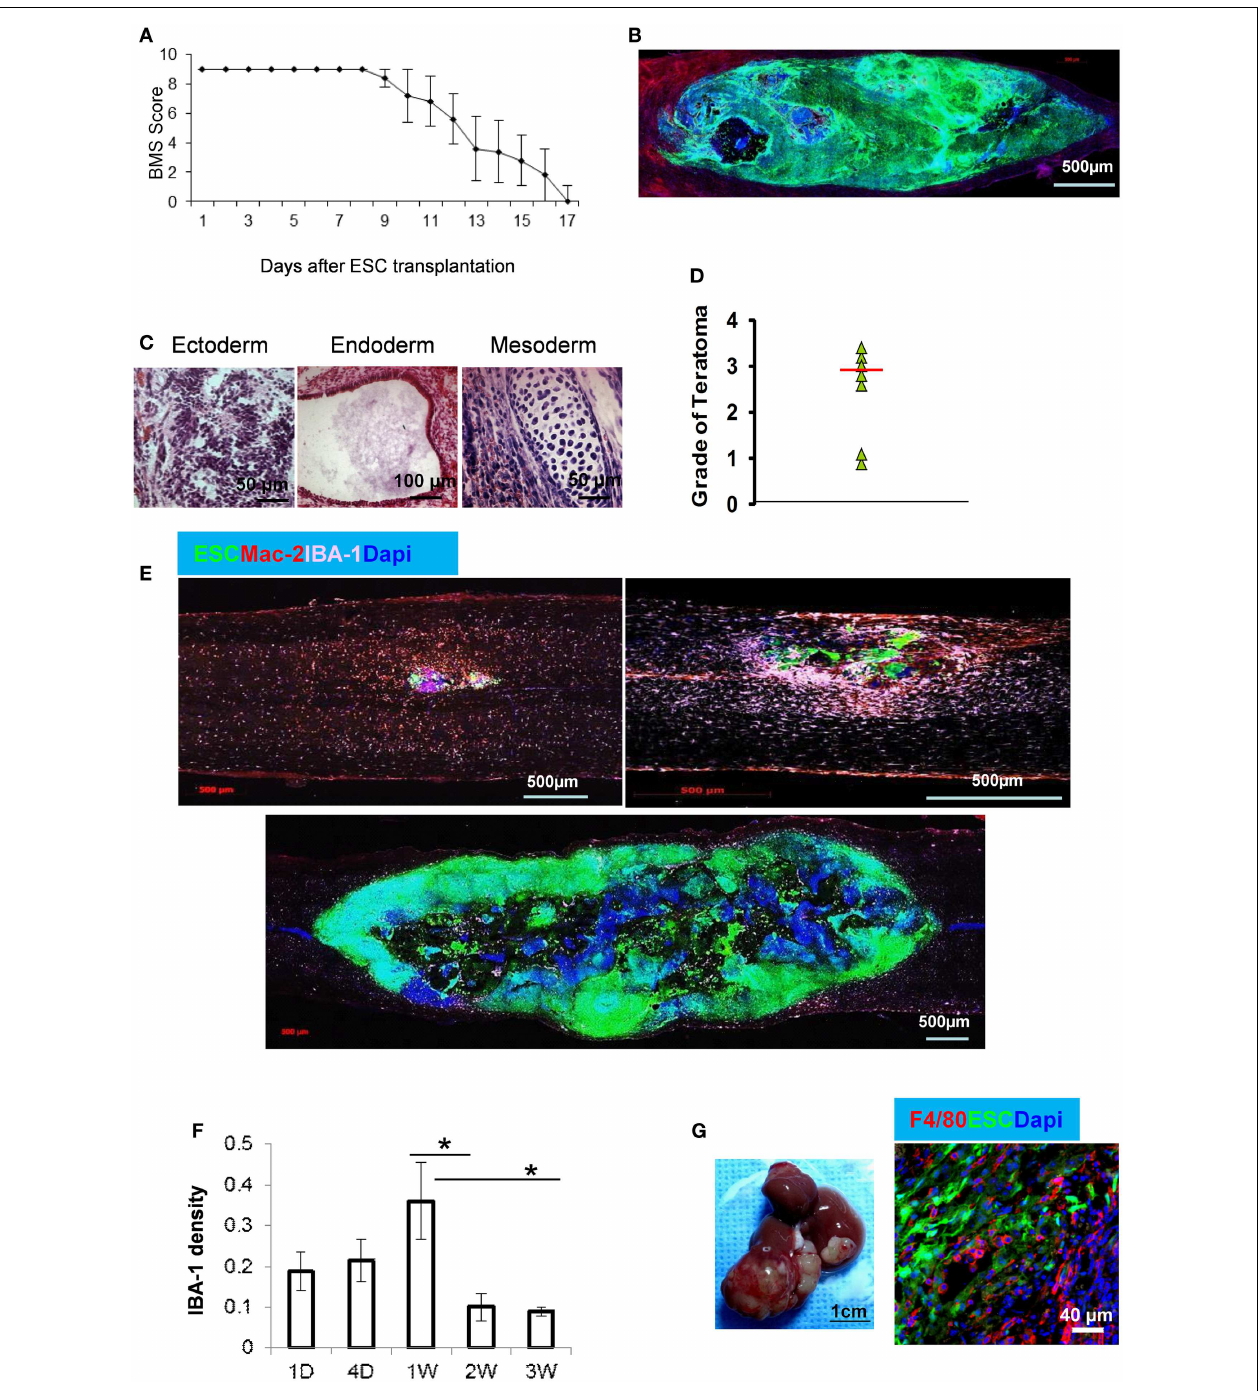
micrographs showing macrophage recruitment during teratoma progression. Macrophages in the sections of spinal cord at 1day (upper left), 1week (upper right), and 3weeks after ESC transplantation (lower) were detected by antibodies to IBA-1 (purple) and Mac-2 (red). (F) Quantification of IBA-1 + macrophages at indicated time points after ESC transplantation ( n = 10, * p < 0.05, two-sidedWilcoxon test. Data are represented as mean ± SEM). (G) Representative gross morphology of teratoma in liver (left) and F4/80 + macrophages in teratoma at 4weeks after ESC transplantation in